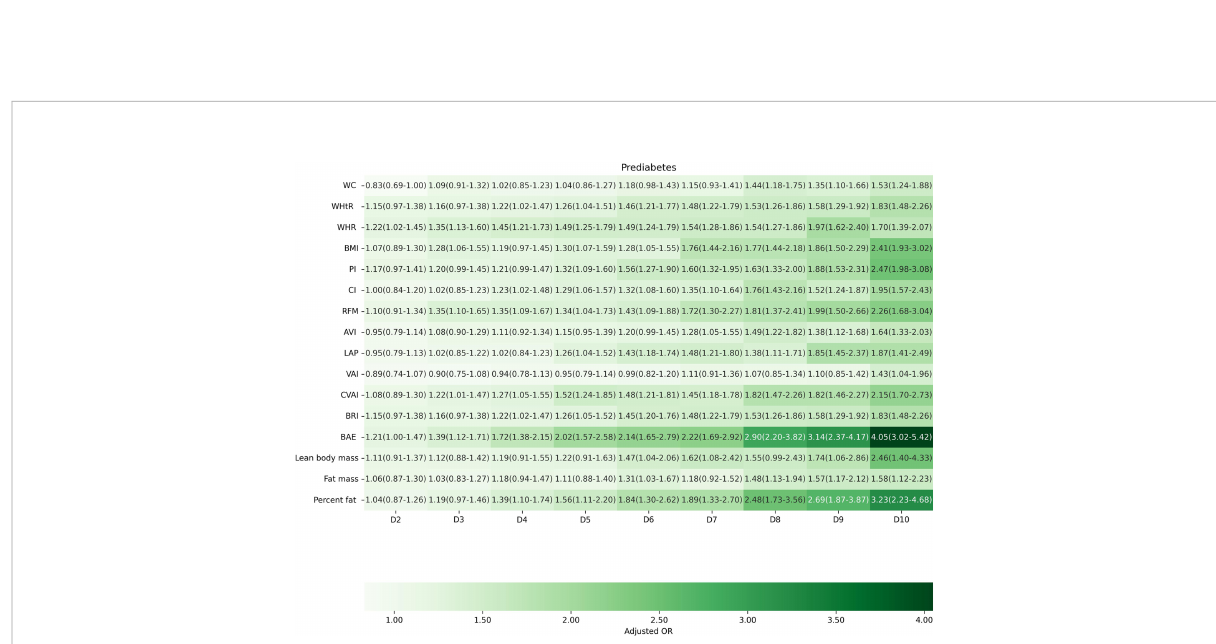
FIGURE 6 The association between deciles of obesity indicators and prediabetes based on the combined criteria of American Diabetes Association. The fi rst decile (D1) was used as reference. Adjusted for age, gender, education level, equivalent household income, drug history, family history of diabetes, smoking status, drinking status, regular exercise, hypertension, TC, LDL-C, HDL-C, and TG; for lean body mass, fat mass and height were further adjusted; for fat mass, lean body mass and height were further adjusted. WC, waist circumference; WHtR, waist-to- height ratio; WHR, waist-to-hip ratio; BMI, body mass index; PI, ponderal index; CI, conicity index; RFM, relative fat mass; AVI, abdominal volume index; LAP, lipid accumulation product; VAI, visceral adiposity index; CVAI, Chinese visceral adiposity index; BRI, body roundness index; BAE, body adiposity